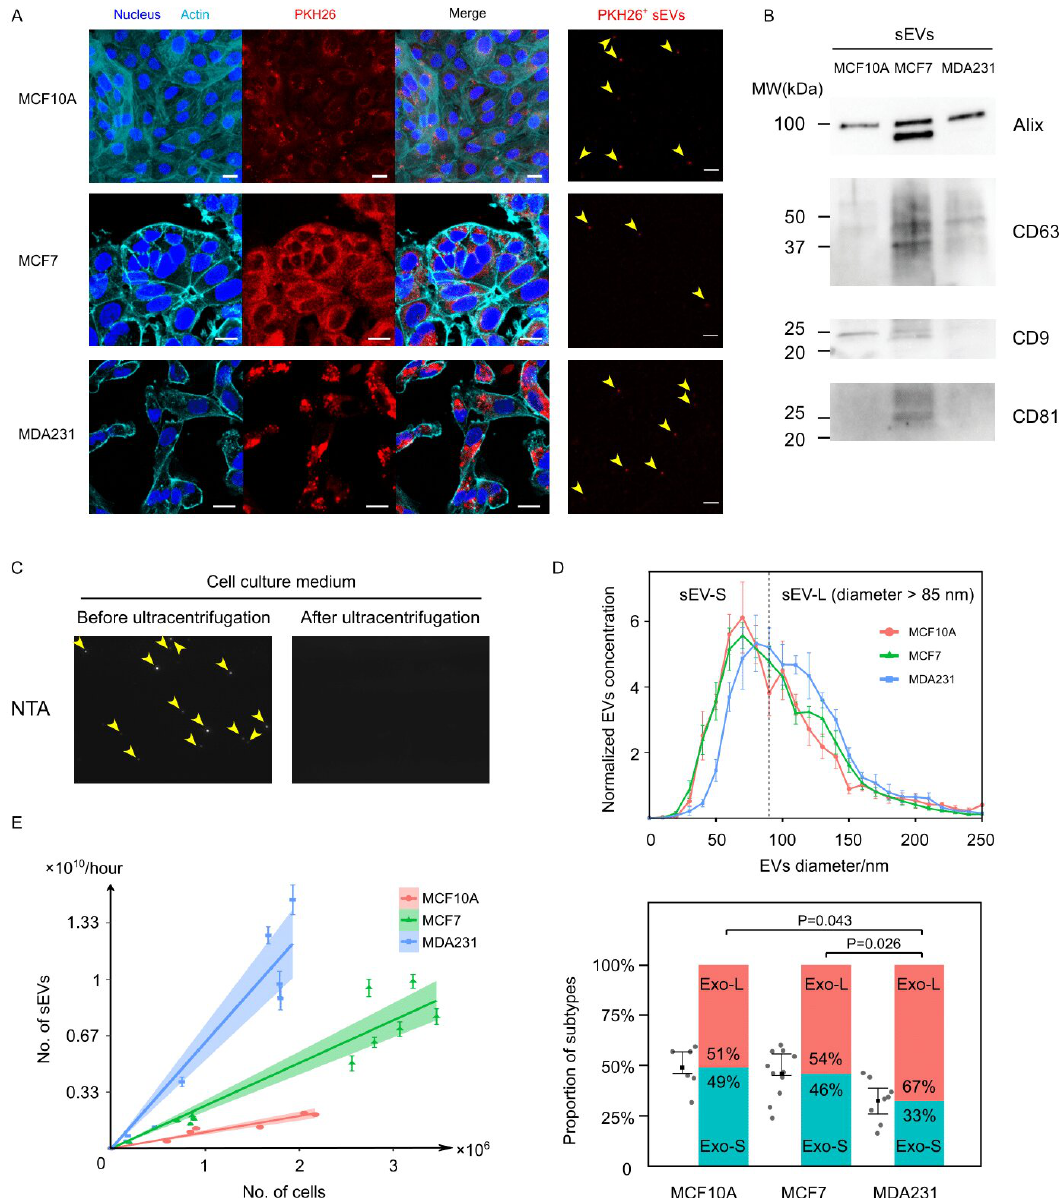
Figure 1. Characterization of cancer and normal cell-derived EVs. ( A ) Breast cell lines MCF10A, MCF7 and MDA231 were stained with cell membrane dye PKH26 and incubated to generate PKH26+ EVs. Scale bars = 20 µm for left three columns and scale bars = 5 µm for the sEVs column. ( B ) An estimated 10 ug of total sEV proteins were used for western blot. The sEV protein markers including Alix, CD63, CD9 and CD81 were enriched. Because the BCA protein assay had limited accuracy at the range of EV protein concentration, the actual amount of protein in each lane might vary. ( C ) Crude EVs in the culture medium were detected and counted by Nanoparticle Tracking Analysis. Ultracentrifugation removed all the detected particles, suggesting that these particles were indeed EVs. ( D ) Normalized size distribution of EV for MCF10A ( N = 6), MCF7 ( N = 11) and MDA231 ( N = 8). The EVs derived from all three cell lines have a diameter of 50–150 nm, with the MDA231-derived EVs showing a rightward shift compared to the other two cell lines. Dividing the EVs into smaller and larger subtypes with a threshold diameter of 85 nm, the MDA231-sEVs constitute prominently higher proportions of sEV-L subtype. Error bars stand for the 25th and 75th percentile. P values are calculated based on Mann–Whitney U test. ( E ) Scatter plot shows EV number and cell number were linearly correlated, with the coefficients distinguishable between cell lines. The rank of the EV generation rate was MCF10A < MCF7 < MDA231. Error bars of each point stand for the standard error of the mean (SEM). Data were fitted by linear regression with zero intercept, with the 95% confidence interval highlighted in color.